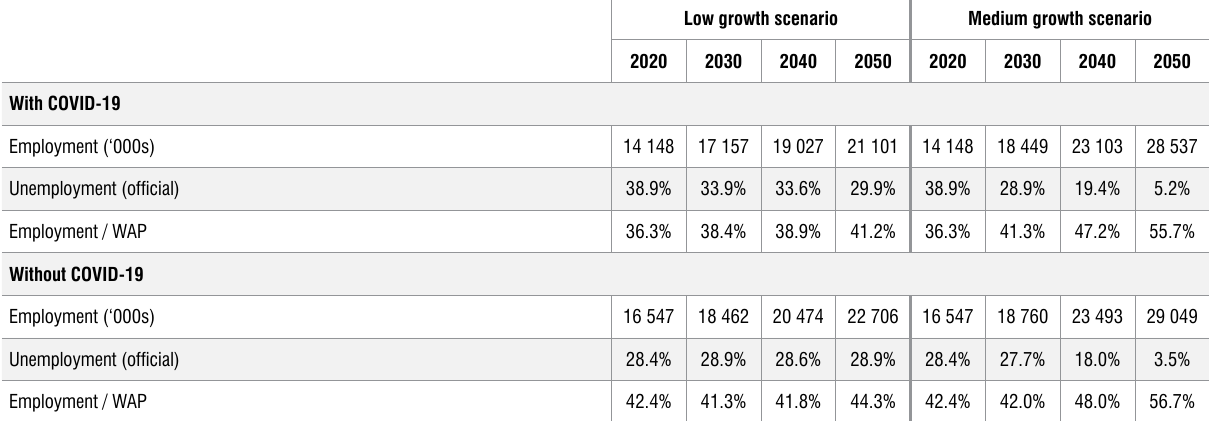
Table 4: Employment scenarios in the absence of COVID-19